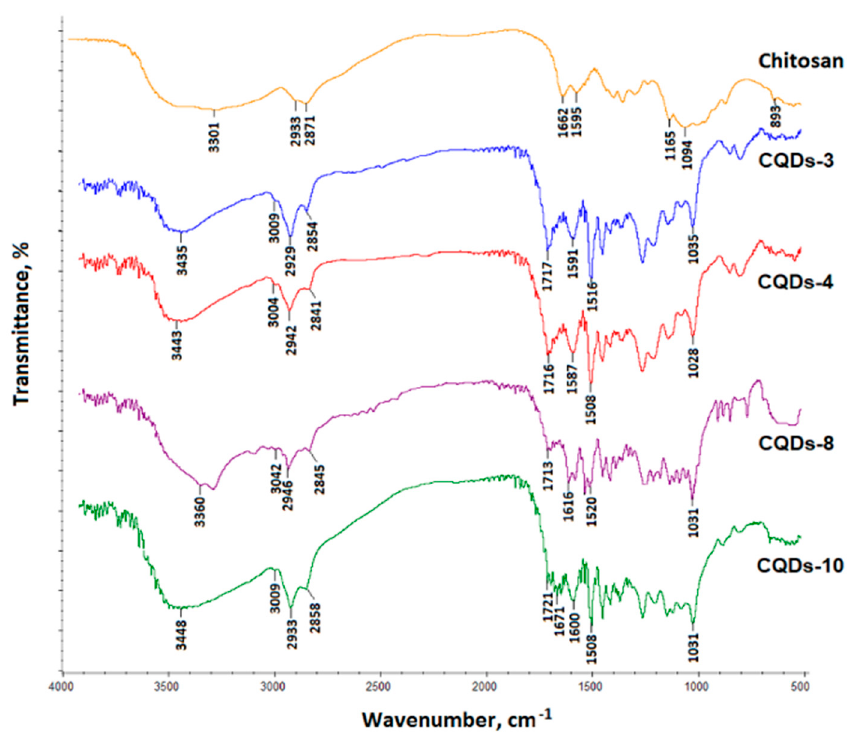
Figure 1. FT-IR spectra of the pure chitosan and CQD samples.